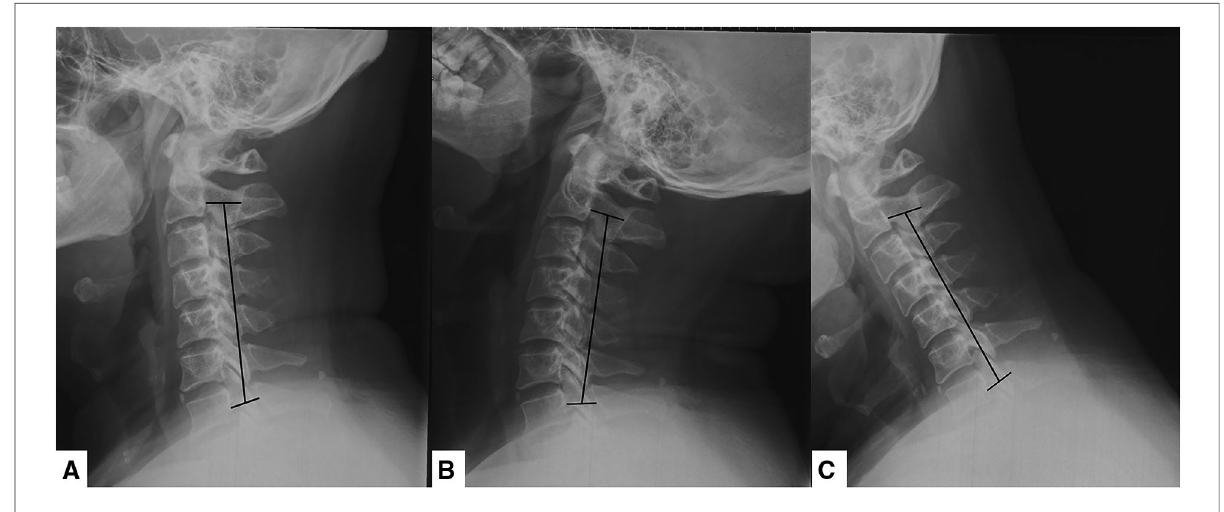
FIGURE 1 Cervical radiographs in different dynamic position. ( A ) Neck-neutral position; ( B ) neck- fl exed position; ( C ) neck-extended